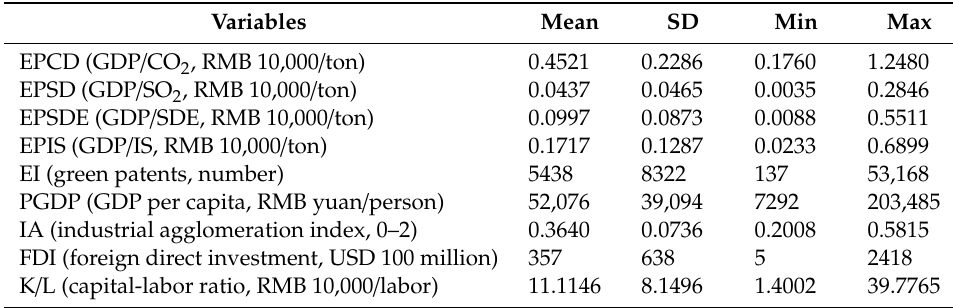
Table 3. Sample statistical values of variables of China’s largest urban agglomerations (as mean, standard deviation (SD), minimum (Min), and maximum (Max)).